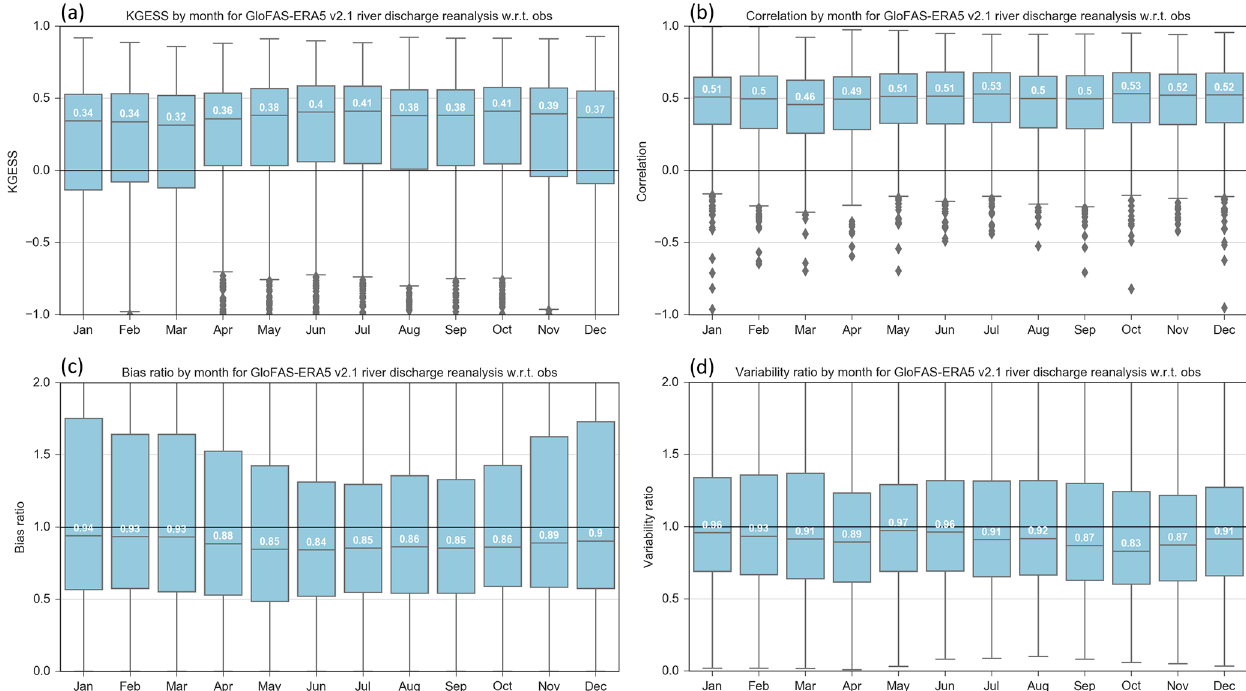
Figure 8. Performance metrics for each month for all 1801 stations. Modified Kling–Gupta efficiency skill score (KGESS) (a) with decom- position of KGE (cid:48) into Pearson correlation (b) , bias ratio (c) , and variability ratio (d) . Boxes represent the IQR and horizontal grey line the median. Whiskers extend to the most extreme data point unless the data point is more than 1.5 times the IQR from the box and is instead represented as an outlier (grey